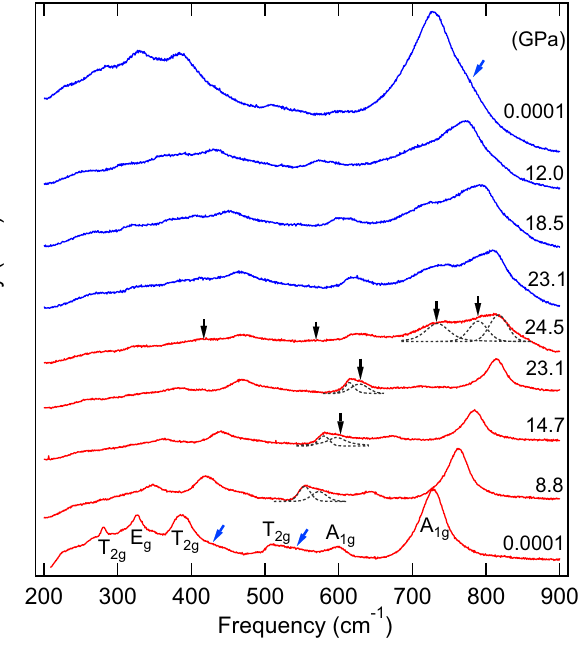
Figure 1. Raman spectra of Mg 2 TiO 4 at pressure to 24.5 GPa and room temperature. A new Raman peak appeared at 14.7 GPa and four additional modes of the high-pressure phase appeared at 24.5 GPa. Red: compression, blue: decompression. Blue and black arrows indicate the Raman modes of spinel and tetragonal phases,